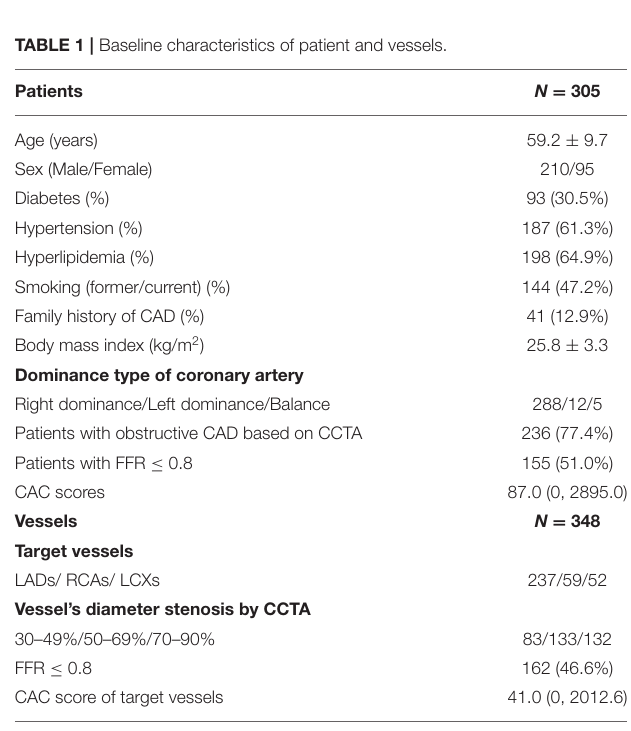
FIGURE 1 | Flow chart of the study. CTA, computed tomography angiography; FFR, fractional flow reserve.